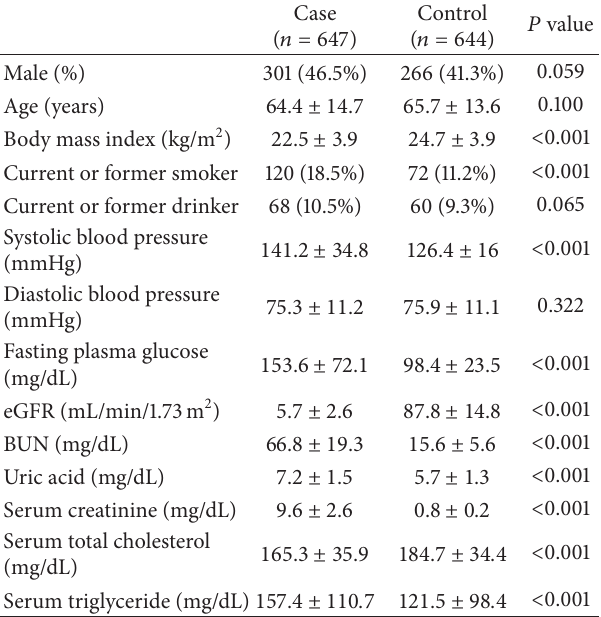
Table 1: Characteristics of study